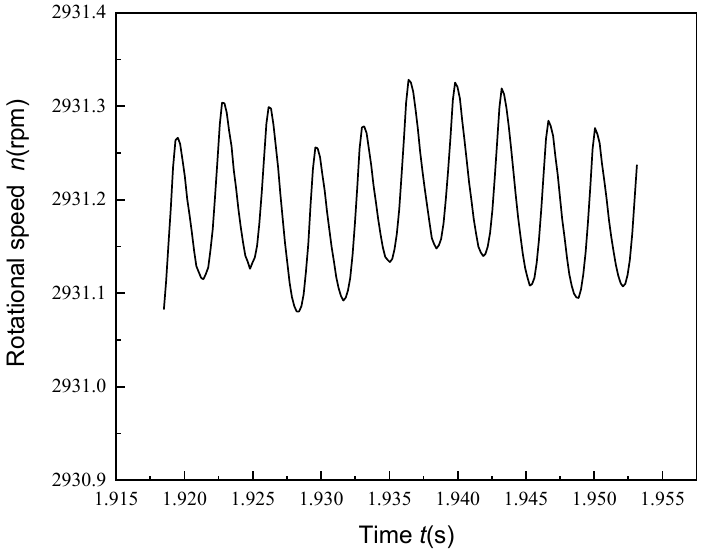
Figure 5. Time-domain diagram of the centrifugal pump’s speed fluctuations.